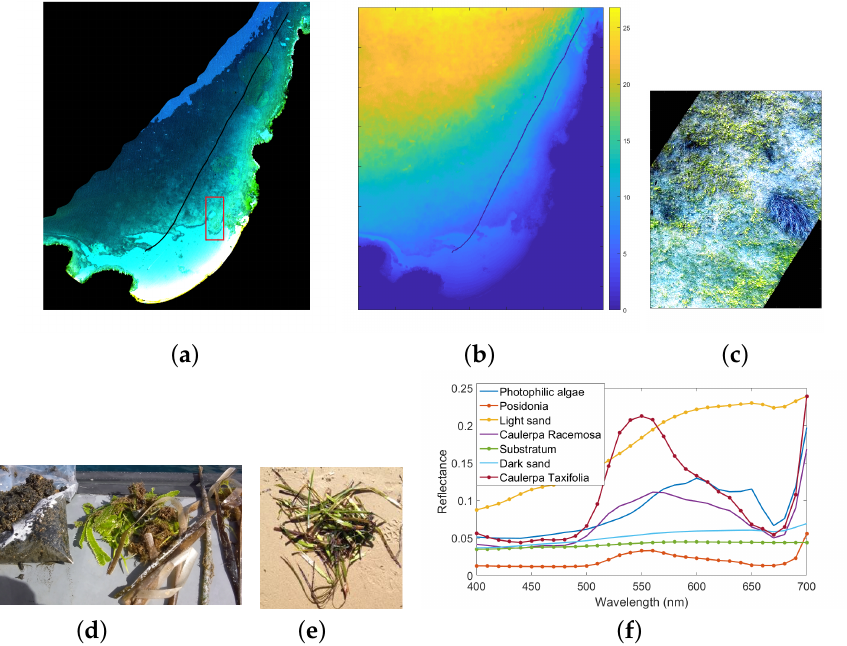
Figure 5. ( a ) Colored composition of the airborne reflectance data of the Porquerolles Island, acquired using the Hyspex hyperspectral sensor (with sub-surface and sun glint correction), with the trace of the ROV transect (black), and local study zone (red rectangle); ( b ) Bathymetry provided by the Litto 3 D data; ( c ) Color image of the seabed given by the Ifremer ROV, showing clear and dark sand, brown Posidonia , and Caulerpa (green); ( d ) Dark substratum, Caulerpa taxifolia and brown colonized Posidonia ; ( e ) Green Posidonia on clear sand; ( f ) Spectral library collected in the coastal zone of Porquerolles Island, used for simulations (the endmembers used for the seabed generation are marked with a